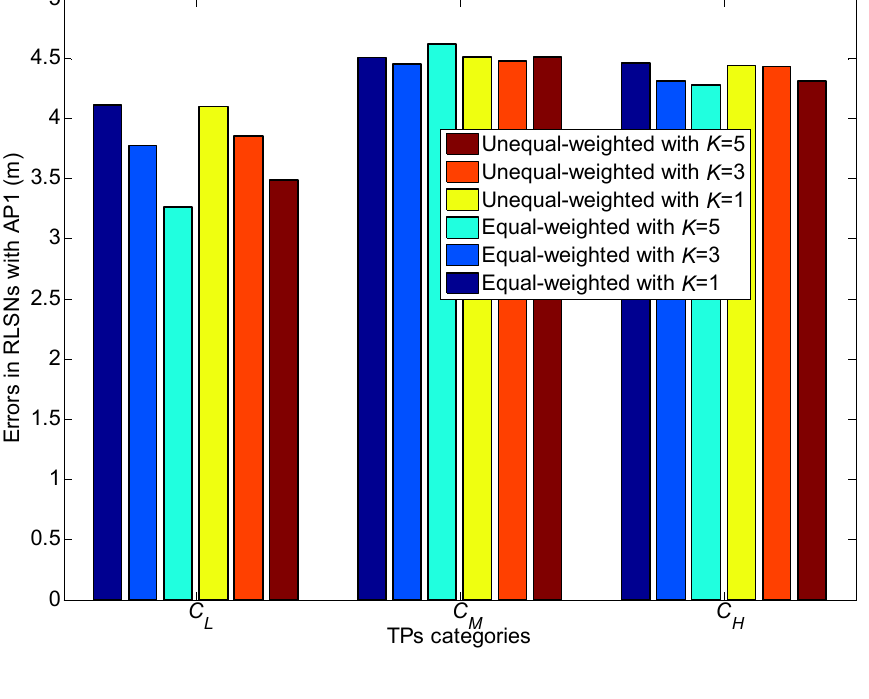
Figure 21. Relations of errors and deviations in equal and unequal-weighted RLSNs ( r = 1